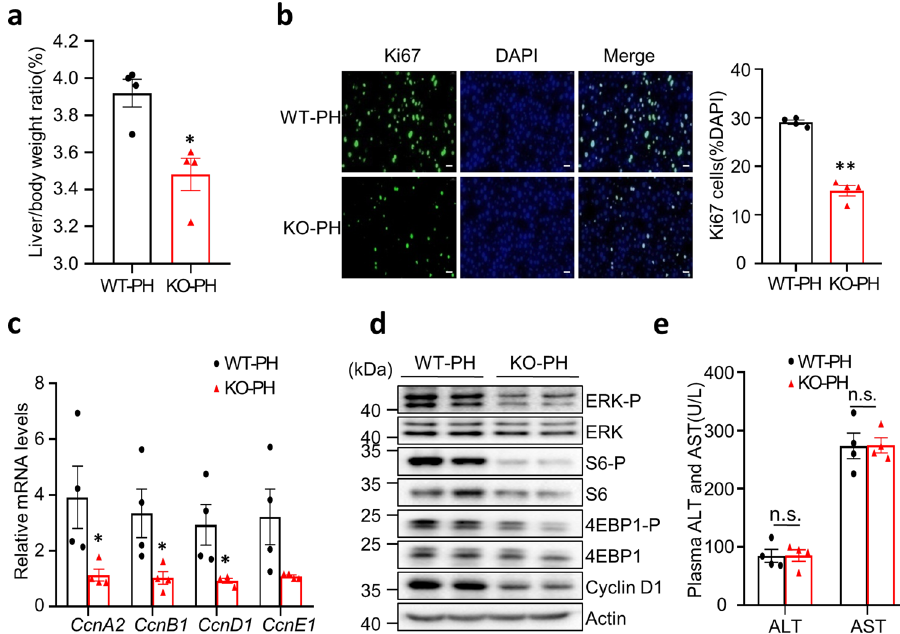
Fig. 1 miR-182-5p de fi ciency suppresses mouse hepatocyte proliferation after 2/3 PH. Male miR-182-5p KO (KO) and WT mice (8-week old) were subjected to 2/3 PH. a Liver to body weight ratio of miR-182-5p KO and WT mice (7d after PH; n = 4/group). b Liver sections were immunostained with an anti-Ki67 antibody. Ki67 + positive cells were counted and normalized to total DAPI + cells (3d after PH; n = 4/group; scale bar: 20 μ m). c qRT-PCR analyses of cyclin gene expression in the liver of miR-182-5p KO and WT mice (3d after PH; n = 4/group). d Lysates of liver homogenates were examined for proliferative signaling by western blot analysis (3d after PH). e Serum AST and ALT levels were measured in miR-182-5p KO and WT mice (3d after PH; n = 4/group). Error bars in all experiments represent SEM; Signi fi cance was determined by unpaired two-tailed Student ’ s t test. * P < 0.05, ** P < 0.01; n.s.: not signi fi